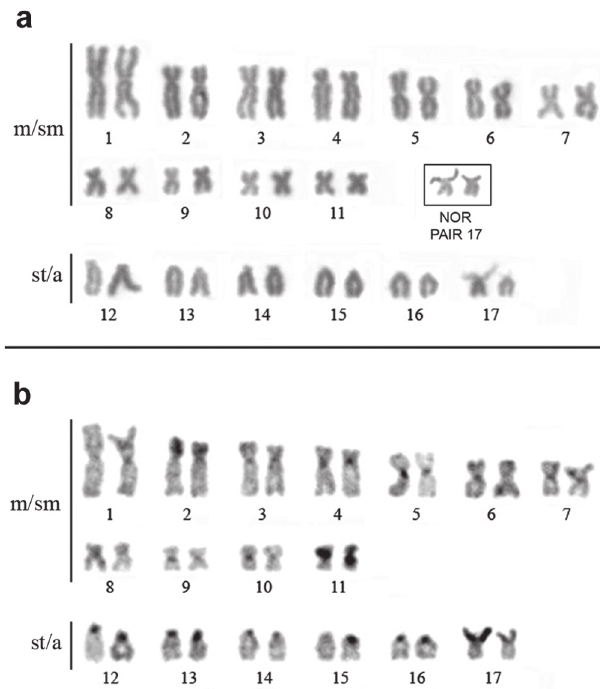
Fig. 5. Karyotype of Eigenmannia sp. “A” with 34 chromosomes. Conventional staining (a) and C banding (b). Box inset: chromosome 17 (p) with NOR. Legend: m/ sm = metacentric/submetacentric and st/a = subtelocentric/ acrocentric.